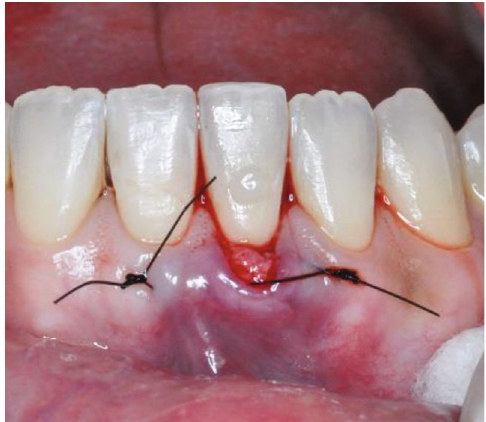
Figure 9: Sutures mesial and distal to the tooth.